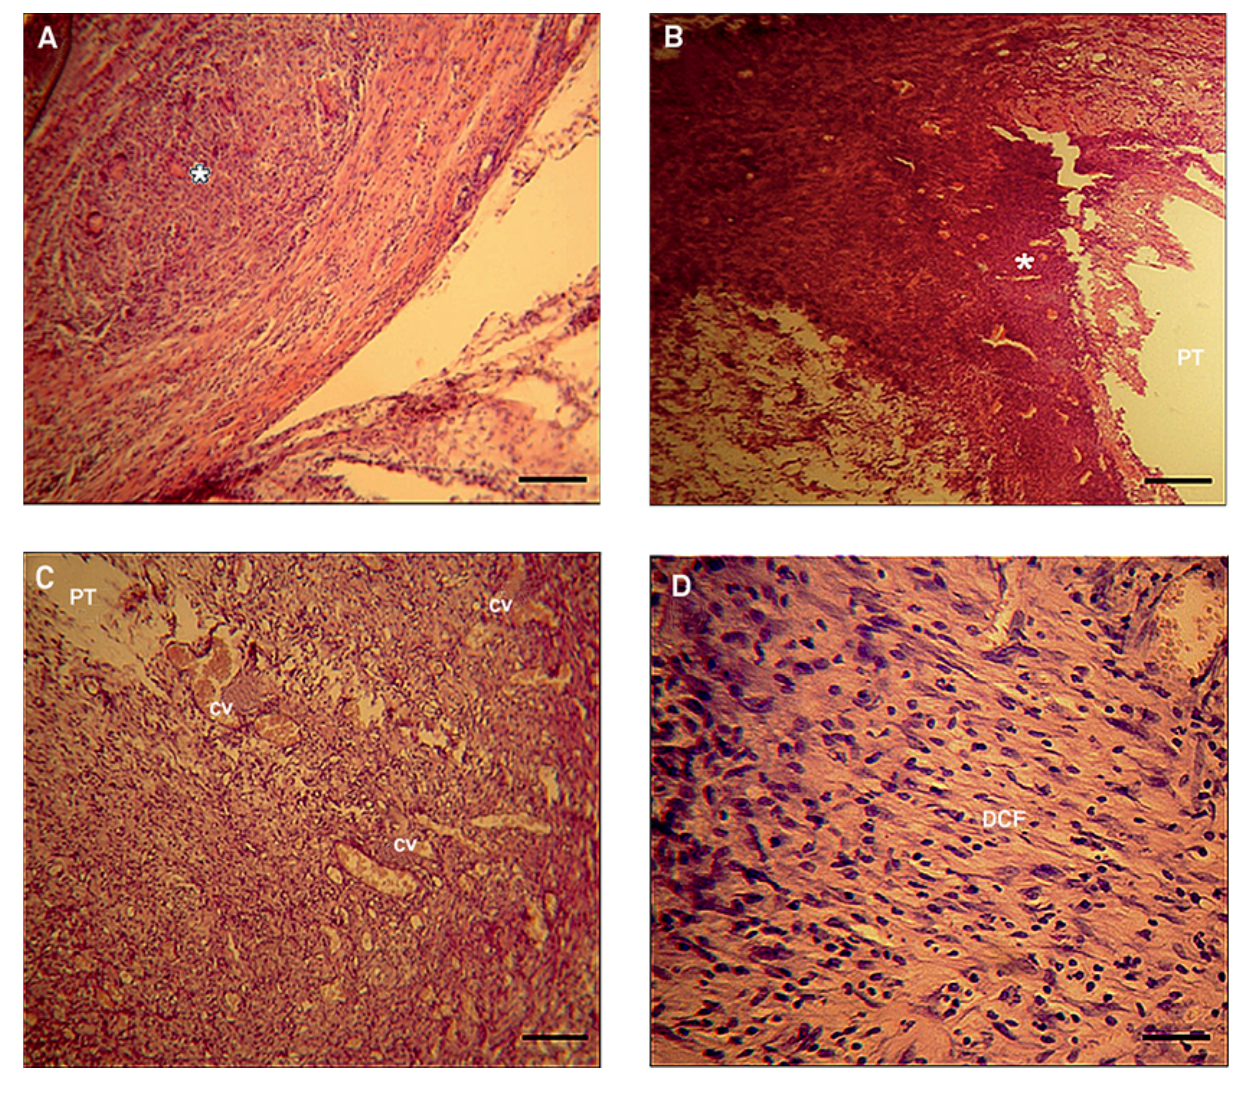
Figure 1. Photomicrograph of a histological sample. a: 15 days after implantation, Group PR: moderate inflammatory infiltrate, with focal distribution (*), composed of numerous multinucleated giant cells (HE,100× magnification; scale: 100 µ m). B: 7 days after implantation, Group KC: focal area (*) of mononuclear inflammatory cells (HE, 100× magnification; scale: 100 µ m). C: 7 days after implantation, Group C (control): granulation reaction area with congested vessels (CV; HE, 100× magnification; scale: 100 µ m). d: 30 days after implantation, Group ME: proliferation of young fibroblasts with a fusiform aspect, in the midst of deposition of collagen fibers (DCF), the majority of which were shown to be disposed in parallel bundles. Diminutive blood vessels could also be seen (HE, 400× magnification; scale: 25 µ m). Area of the polyethylene tube implant